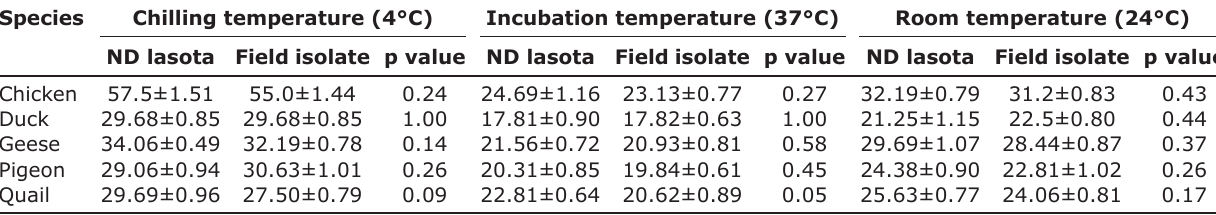
Table-7: Comparing time requirement (min) of HA activity of avian RBC with two strains of NDV at different temperatures. Species